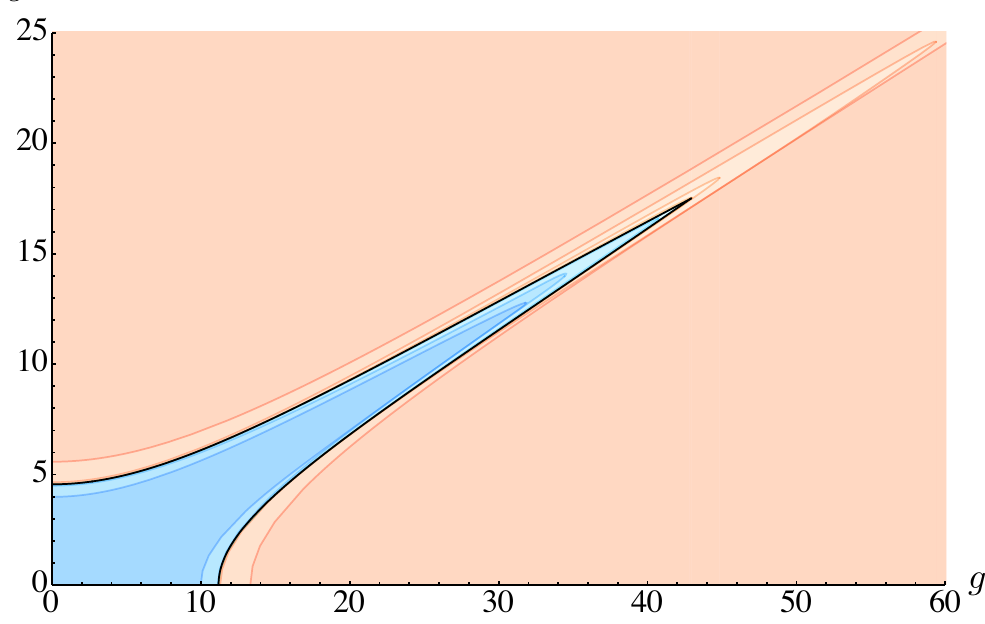
Figure 2 . Numerical bounds on the coupling space { g 111 , g 112 } . The blue shaded regions enclose the allowed points for different N max in our primal ansatz. The red shaded regions mark the points that are rigorously excluded. The thin black analytic curve is the boundary of the allowed region [17]. As we increase N max from 1 to 5 in the primal problem, the blue regions enlarge, allowing for more and more points and eventually converging to touch the boundary of the permitted space (this is more evident in the “horn” region). In the dual strategy as we increase N max from 1 to 5 we exclude more and more points. At convergence the excluded region touches the boundary of the allowed space. We restrict the plot to the first quadrant since it is symmetric under g ↔ − g